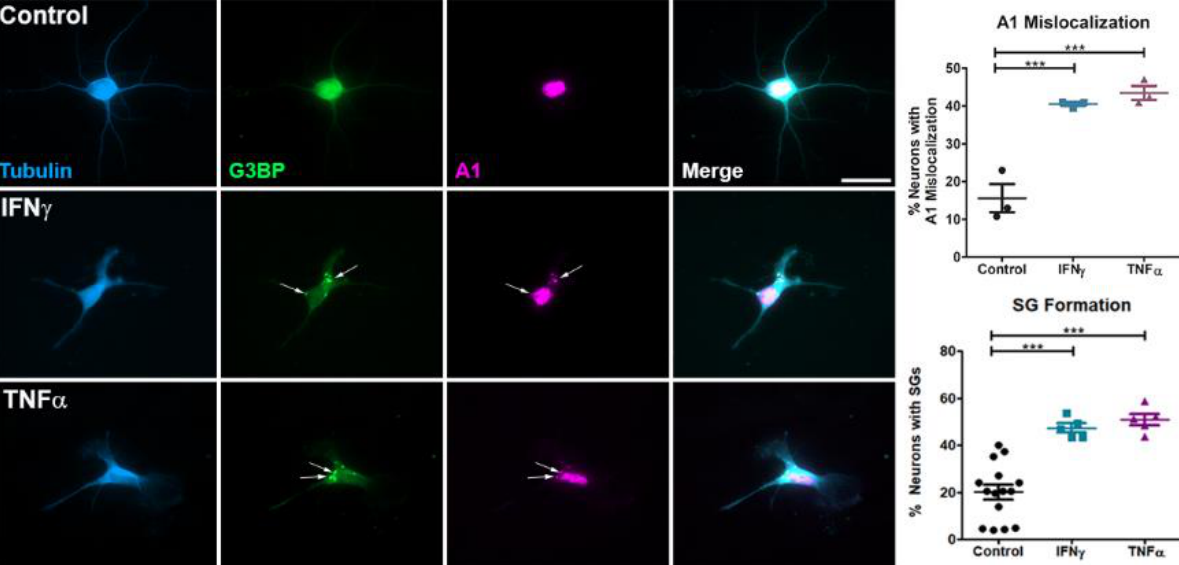
Figure 1. IFNγ and TNFα induce A1 mislocalization and SG formation in neurons. Primary neurons were treated with IFNγ or TNFα and assessed for A1 mislocalization (magenta) and SG formation (G3BP, green). In contrast to control neurons, IFNγ and TNFα-treated neurons displayed significant A1 mislocalization and cytoplasmic SG formation. Mislocalized A1 also colocalized with SGs in both IFNγ and TNFα-treated neurons (arrows). There was no difference in A1 mislocalization or SG formation between the cytokine-treated neurons. One-way ANOVA with Tukey’s post hoc tests with *** p < 0.001. Data are plotted as the mean of each replicate +/− SEM. Scale bar 20 μm.